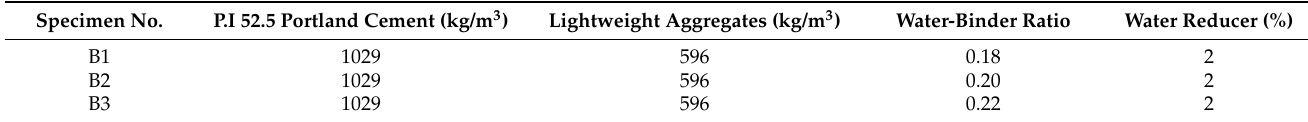
Table 3. The designed mix proportion of series B